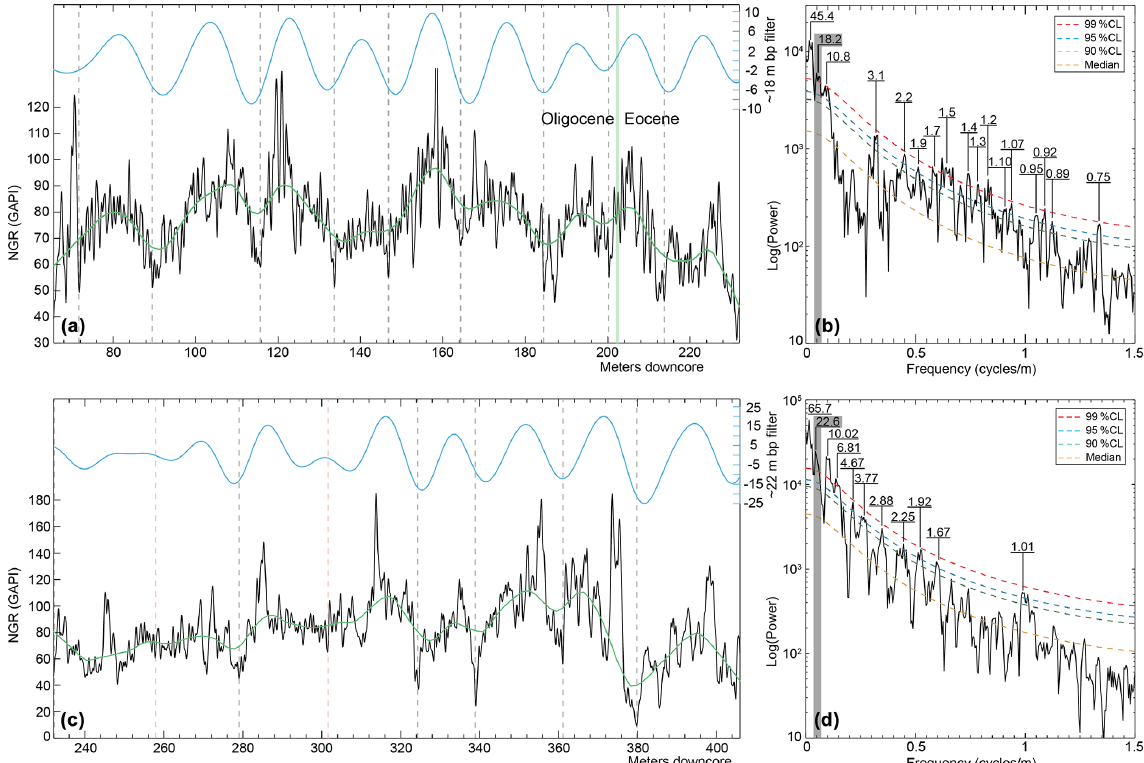
Figure 3. Time-series analysis per interval I1 (65.5–232m) and I2 (232–406m (see Fig. 2)) of the untuned NGR variations. (a) Interval I1, along with 18.2m band-pass filtered (as in Fig. 2) and smoothed with a 8% weighted average of the series. (b) 2 π -MTM power spectrum of interval I1. (c) Interval I2, along with 22.6m band-pass filtered (as in Fig. 2) and smoothed with a 8% weighted average of the series. (d) 2 π -MTM power spectrum of interval I2. Grey-shaded vertical bars in (b) and (d) correspond to the filtered cyclicity in (a) and (c) . All spectral periods in (b) and (d) are expressed in